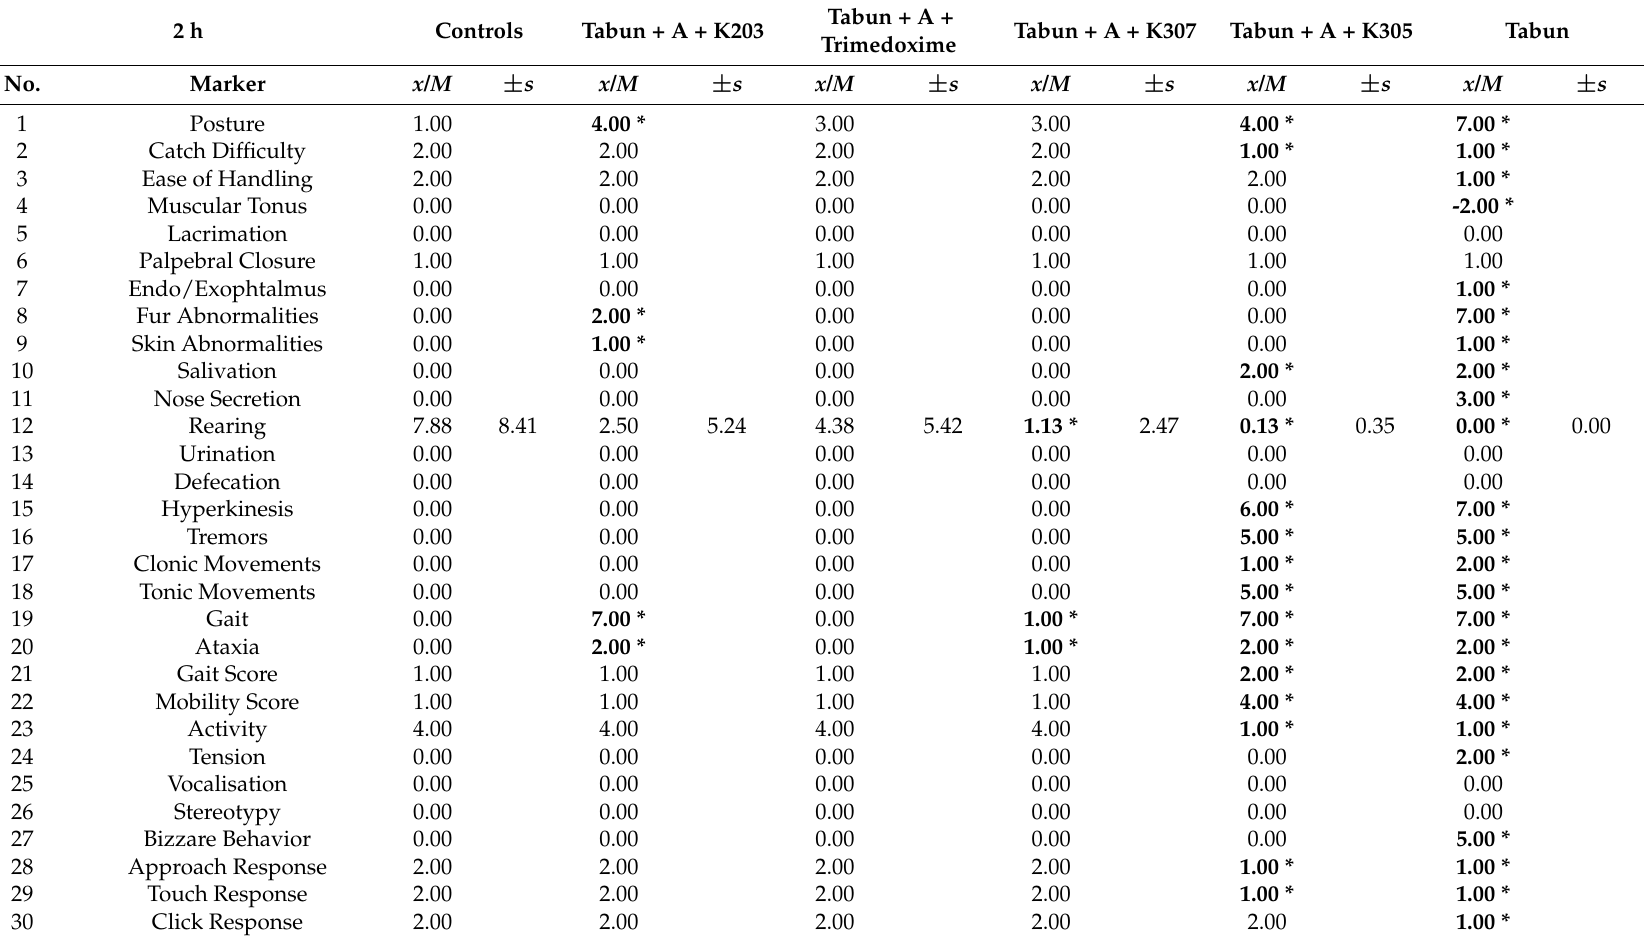
Table 1. The values of tabun-induced neurotoxic markers measured at 2 h following tabun challenge by the functional observational battery (No. 1–11, 15–35—scored values, No. 12–14, 36–42—values in absolute units). Statistical significance: * p < 0.05 (comparison with the control values). Applied abbreviations: RRF, air righting reflex; RRV, air righting reflex from vertical position; x/M , average or modus value; ± s , standard deviation; A, atropine; n, number of surviving